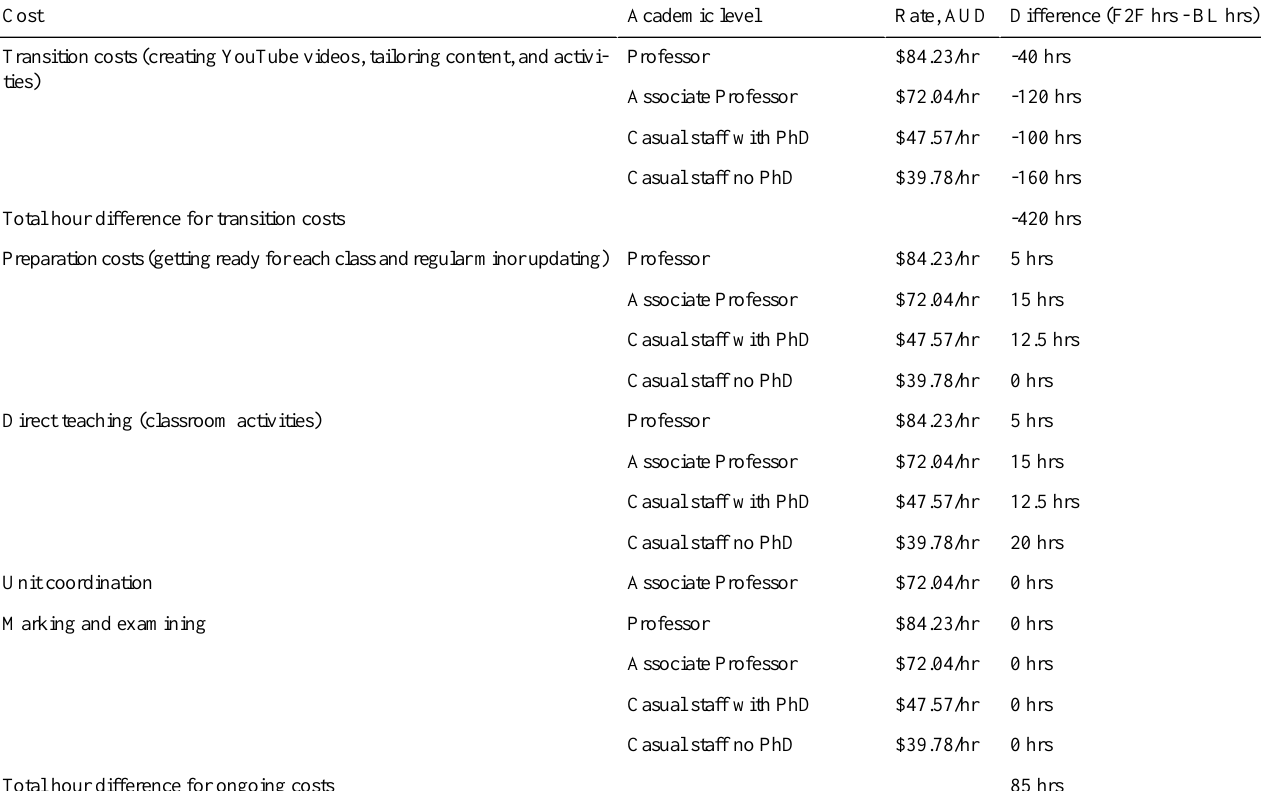
Table 3. Staffing profile with difference in hours for F2F and BL approaches.